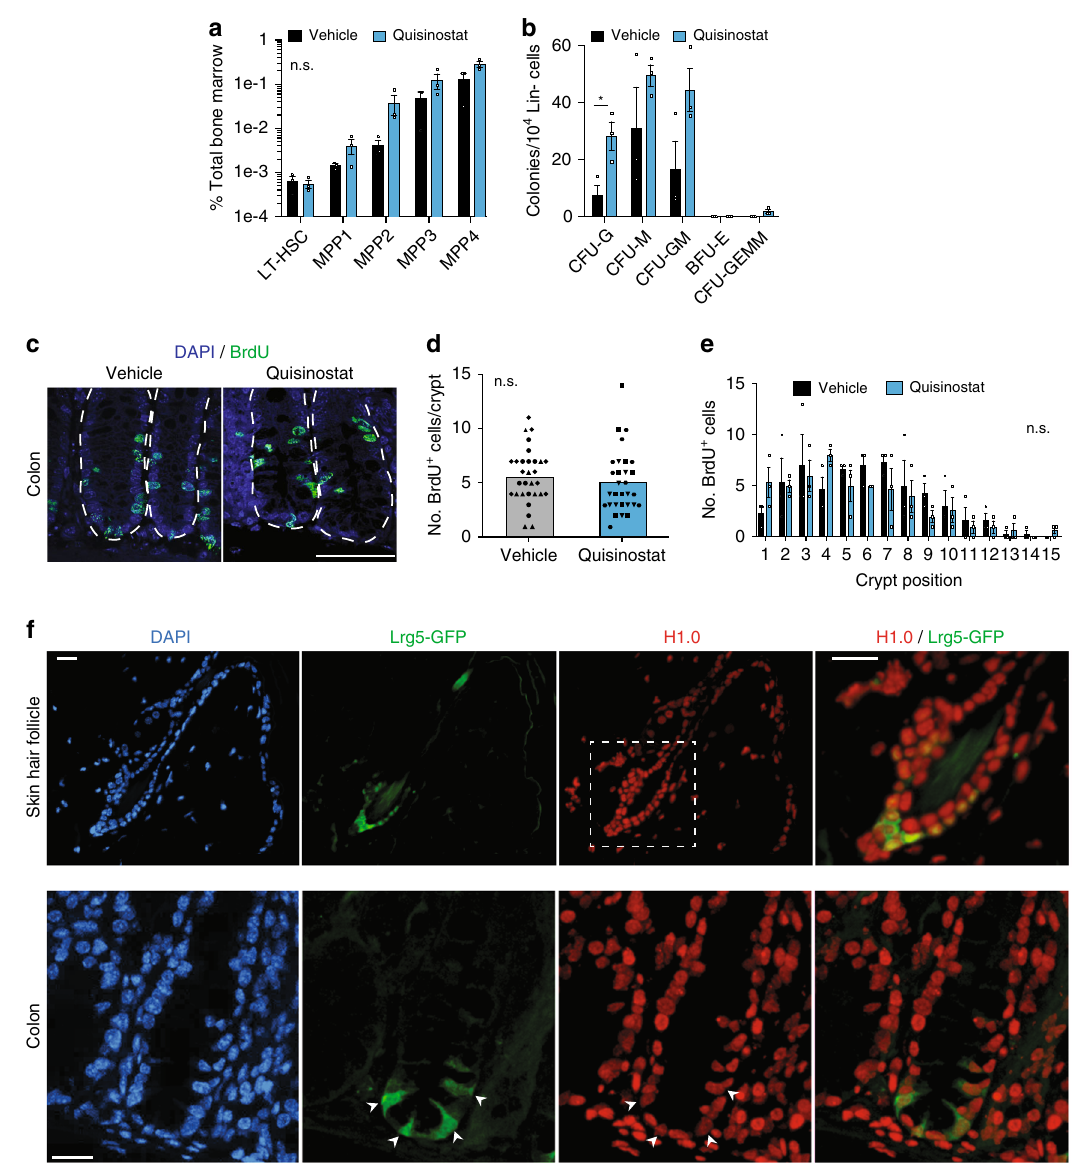
Fig. 3 Quisinostat treatment does not impair normal tissue stem cell function. a , b Relative abundance of long-term hematopoietic stem cells (LT-HSCs) and multipotent progenitors 1 – 4 (MPPs 1 – 4) in the bone marrow of vehicle- or Quisinostat-treated mice as assessed by fl ow cytometry ( a ) or colony assay ( b ). Colony-forming units (CFU) per 10,000 lineage negative (Lin − ) cells extracted from femurs of vehicle- or Quisinostat-treated mice and plated in methylcellulose for 7 days ( b ). CFU-G (granulocyte), CFU-M (macrophages), CFU-GM (granulocyte/macrophages), BFU-E (Burst-Forming Unit- Erythroid), CFU-GEMM (Granulocyte/Erythrocyte/Macrophage/Megakaryocyte). Values are mean ± s.e.m. from three mice per treatment condition. The differences between treated and untreated cells for each cell type in both panels is not signi fi cant (n.s. p > 0.05) except for CFU-G, where * p = 0.02, (two- tailed Student ’ s t -test). c Immunodetection of dividing cells (BrdU + , green) in the colon crypts in Quisinostat- or vehicle-treated mice. Cell nuclei are marked by DAPI (blue). Dotted lines indicate crypts. Scale bars: 100 μ m. d Quanti fi cation BrdU + cells per colon crypt in Quisinostat- or vehicle-treated mice. Each point represents an individual crypt from three mice, ten crypts analyzed per mouse, with different symbols indicating crypts from different mice. Bars indicate the median value. n.s.: non-signi fi cant ( p = 0.4199, unpaired two-tailed Students ’ t -test). e Distribution of BrdU-positive cells across crypt positions in Quisinostat- or Vehicle-treated mice. Position 1 represents the fi rst cell in crypt away from the midline. Values represent mean ± s.e.m. from three mice, with ten crypts quanti fi ed for each mouse. n.s.: non-signi fi cant ( p = 0.5346, two-way ANOVA). f Immunodetection of H1.0 in colon and hair follicle stem cells marked by Lrg5. Tissues are from transgenic mice expressing GFP under the control of the endogenous Lrg5 promoter 28 . Scale bars: 20 μ m. For the skin hair follicle, the area in the white square is shown at a higher magni fi cation as merge. For the colon, the white arrows indicate Lrg5 + cells. Similar patterns were observed in three sections. Data for all graphs is in Source Data fi demonstrate that Quisinostat impairs cancer cell self-renewal and tumor maintenance primarily by restoring high levels of H1.0.